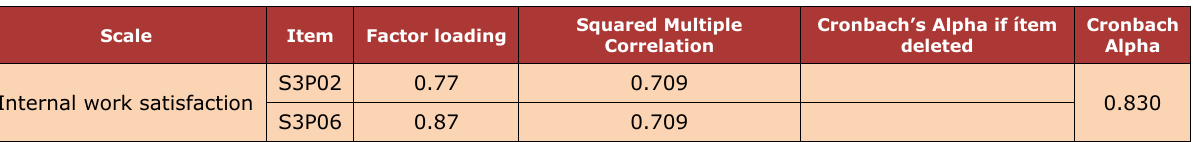
Table 8. Internal consistency of the respecified model